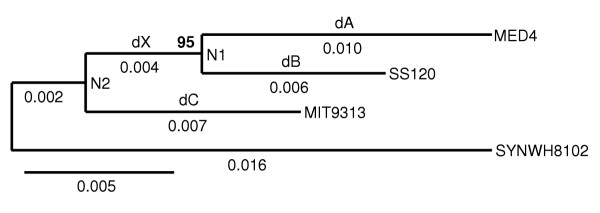
Phylogenetic tree of 16S rRNA genes from the four marine picocyanobacteria. Neighbor-joining tree with Kimura 2-parameter correction. The bootstrap value (1,000 replications) is shown in boldface. Lengths of the branches dA, dB, dC and dX (see text) are given below the branches. N1, node 1, branchpoint between MED4 and SS120; N2, node 2, branchpoint between MIT9313 and Node 1.